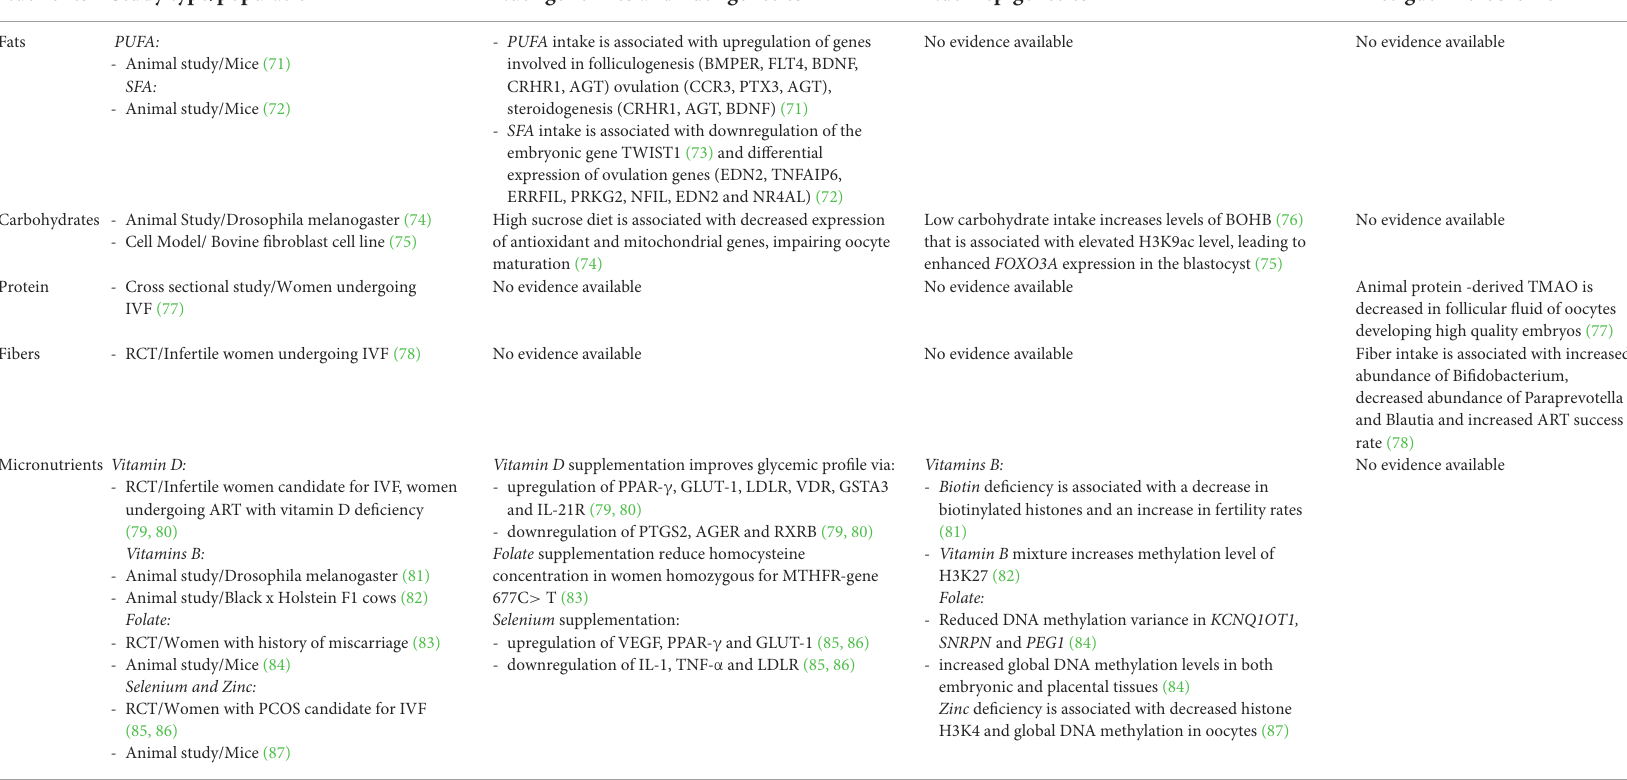
PUFA,Polyunsaturatedfattyacids;BMPER,BMPBindingEndothelialRegulator;FLT4,FmsRelatedReceptorTyrosineKinase4;BDNF,Brain-derivedNeurotrophicFactor;CRHR1,CorticotropinReleasingHormoneReceptor1;AGT,Angiotensinogen; CCR3,ChemokineReceptor3;PTX3,Pentraxin3;SFA,SaturatedFattyAcids;TWIST1,Twist-Relatedprotein1;EDN2,Endothelin2;TNFAIP6,TumorNecrosisFactor-InducibleGene6;ERRFIL,ERBBReceptorFeedbackInhibitor1;PRKG2,Protein KinaseCGMP-Dependent2;NFIL,NuclearFactor,Interleukin3;NR4AL,NuclearReceptorSubfamily4GroupAMember1;BOHB, β -hydroxybutyrate;H3K9ac,Histone3Lysin9Acetylation;FOXO3A,ForkhedBoxO3;TMAO,Trimethylamine-N- Oxide; ART, Assisted reproductive technology; PPAR- γ , Peroxisome Proliferator- Activated Receptors; GLUT-1, Glucose Transport; LDLR, Low-Density Lipoprotein Receptor; VDR, Vitamin D Receptor; GSTA3, Glutathione S-TransferaseA3; IL-21R, Interleukin21Receptor;PTGS2,Prostaglandin-EndoperoxideSynthase2;AGER,AdvancedGlycosylationEnd-ProductSpecificReceptor;RXRB,RetinoidXReceptorBeta;VEGF,VascularEndothelialGrowthFactor;IL-1,Interleukin1;TNF- α ,Tumor